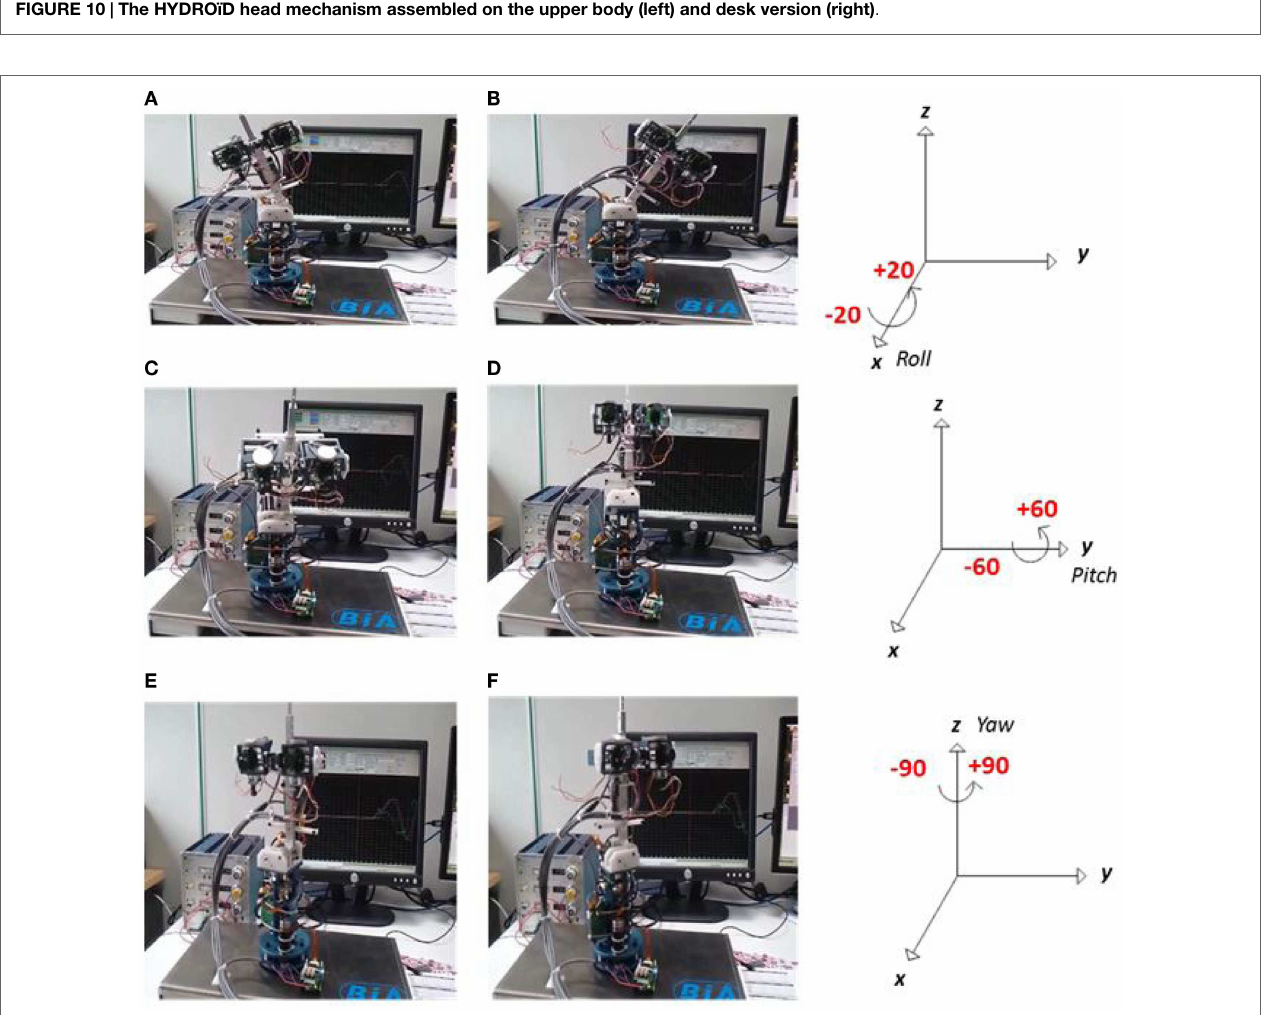
controller of therobot atfrequency of1000 Hz. The ball is detected in the visual field using its color. The resulting projections of the ball are approximated on Gaussian filter in order to reduce noise.